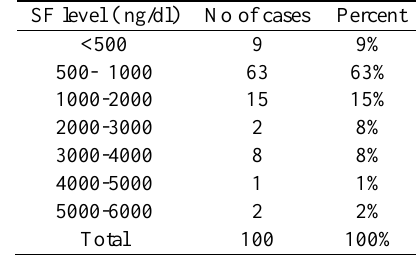
Table 3: serum ferritin levels after desferrioxamine chelation